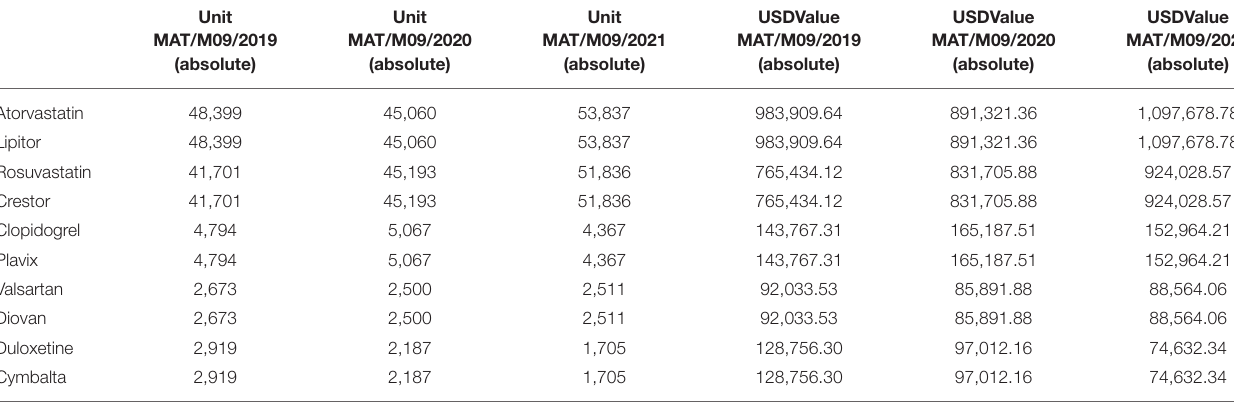
TABLE 4 | Empirical data on sales units and volumes of Kenya 2019–2021.